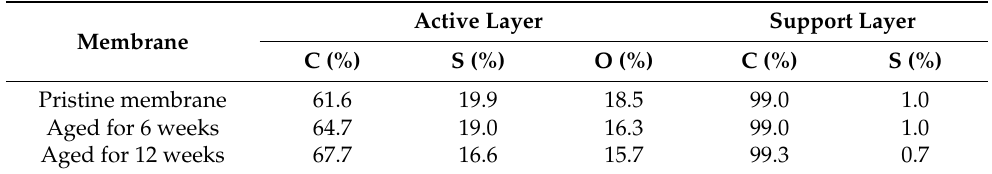
Table 2. EDS analysis of active and support layers of polymeric membranes (pristine, 6 and 12 weeks aged prior to NF test). Active Membrane